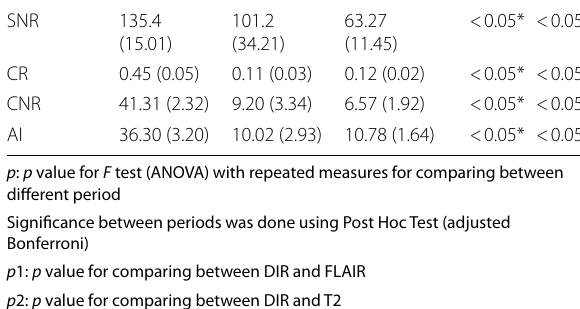
Table 2 contrast measurements in patients with MTS compared between DIR, FLAIR, and T2 MRI (Data expressed as means (SDs))